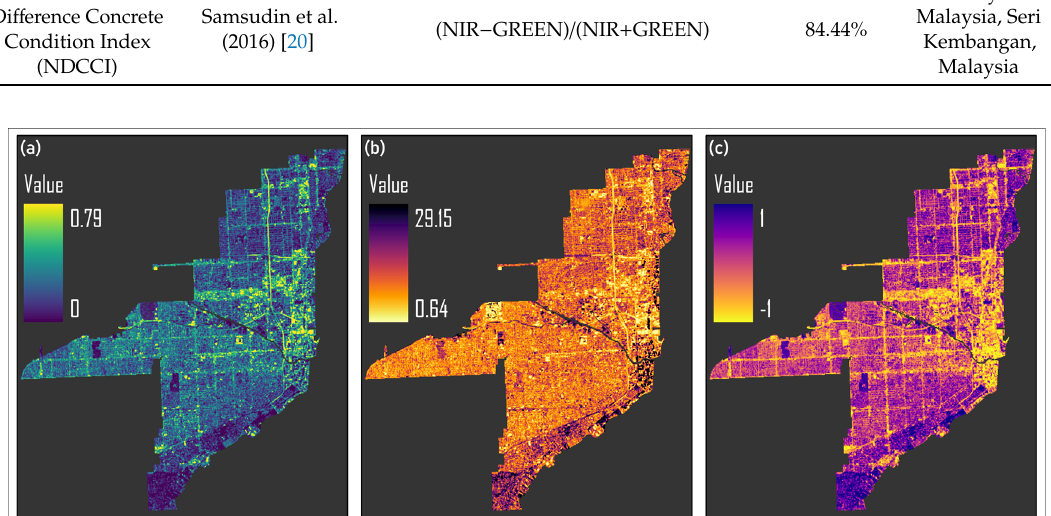
Figure 2. Select spectral enhancements derived from Landsat 8 OLI 22 October 2016 data; ( a ) NBI, ( b ) BAEI, ( c )